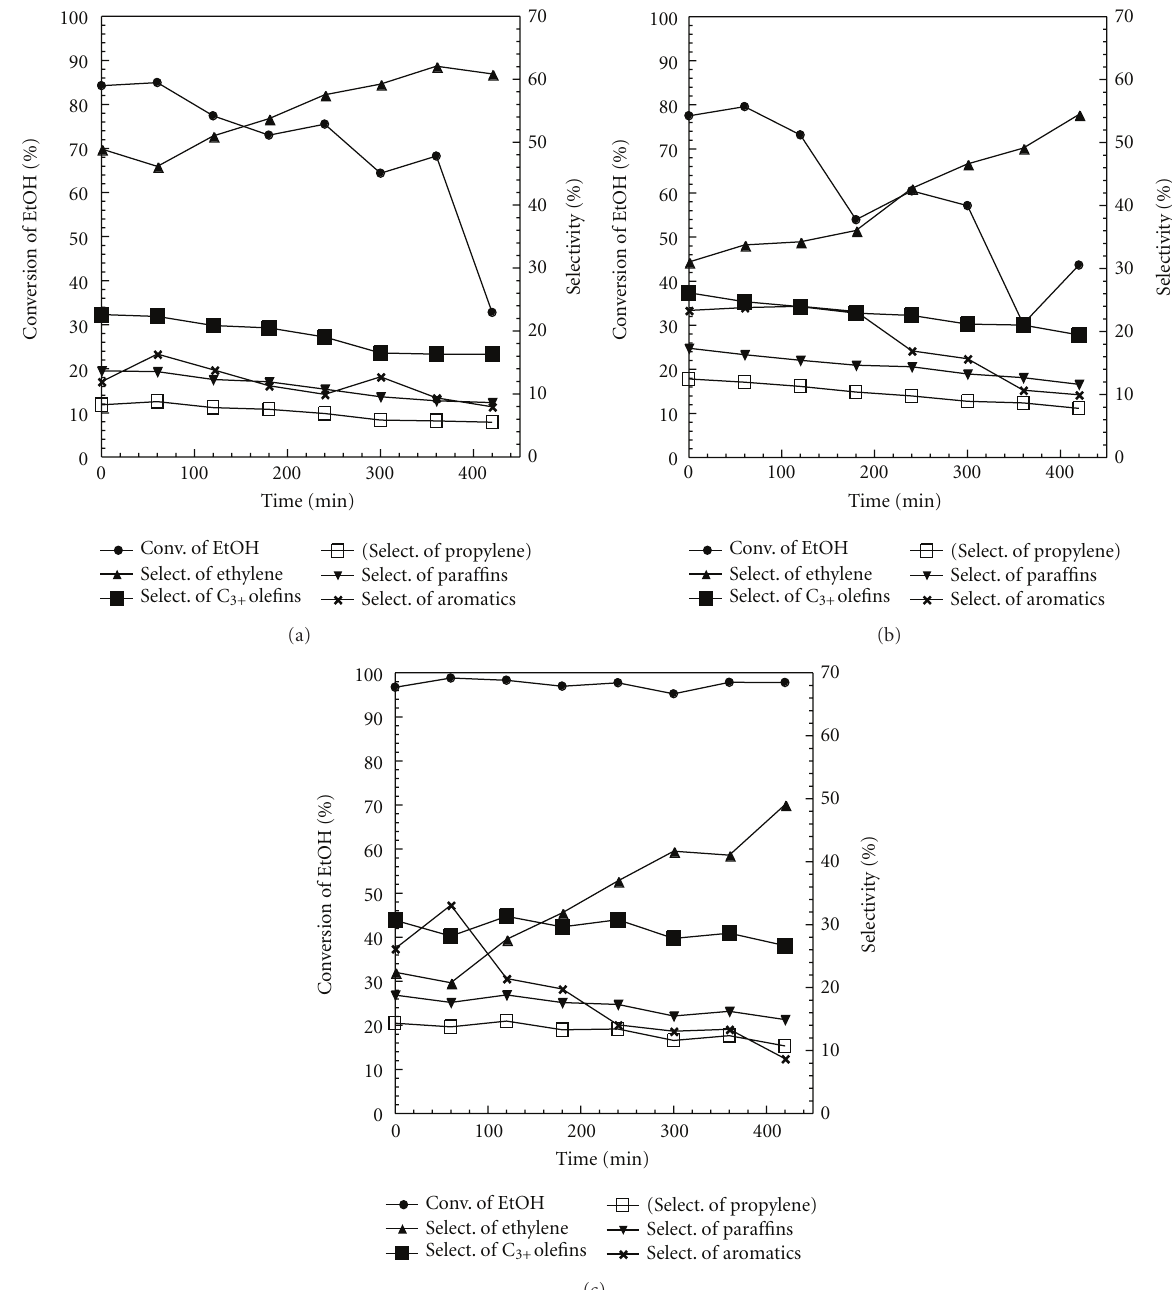
Figure 5: Catalytic performance as a function of time. (a) H-ZSM-5 (700) using neat EtOH, (b) Zr/H-ZSM-5 (Zr = 5wt%) using neat EtOH, and (c) Zr/H-ZSM-5 (Zr = 5wt%) using mixture of vodka and